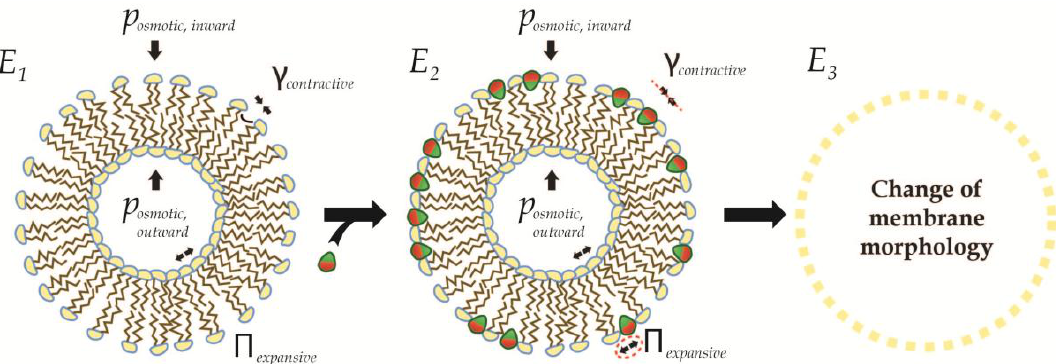
Figure 8. Change of the membrane substrate upon amphiphile insertion. Liposome morphologies are stabilized by opposing forces ( left ), which are generally speaking a combination of contractive forces (surface tension 𝛾 and inward osmotic pressure 𝑝 𝑜𝑠𝑚𝑜𝑡𝑖𝑐,𝑖𝑛𝑤𝑎𝑟𝑑 ) and expansive forces (lateral pressure Π and outward osmotic pressure 𝑝 𝑜𝑠𝑚𝑜𝑡𝑖𝑐,𝑜𝑢𝑡𝑤𝑎𝑟𝑑 ) . Insertion of amphiphiles reduced the surface tension (see red dashed line), while increasing the lateral pressure (see dashed red ellipse), and thereby tips the balance in favor of the expansive forces ( middle ). As a consequence, the membrane will change morphology ( right ).